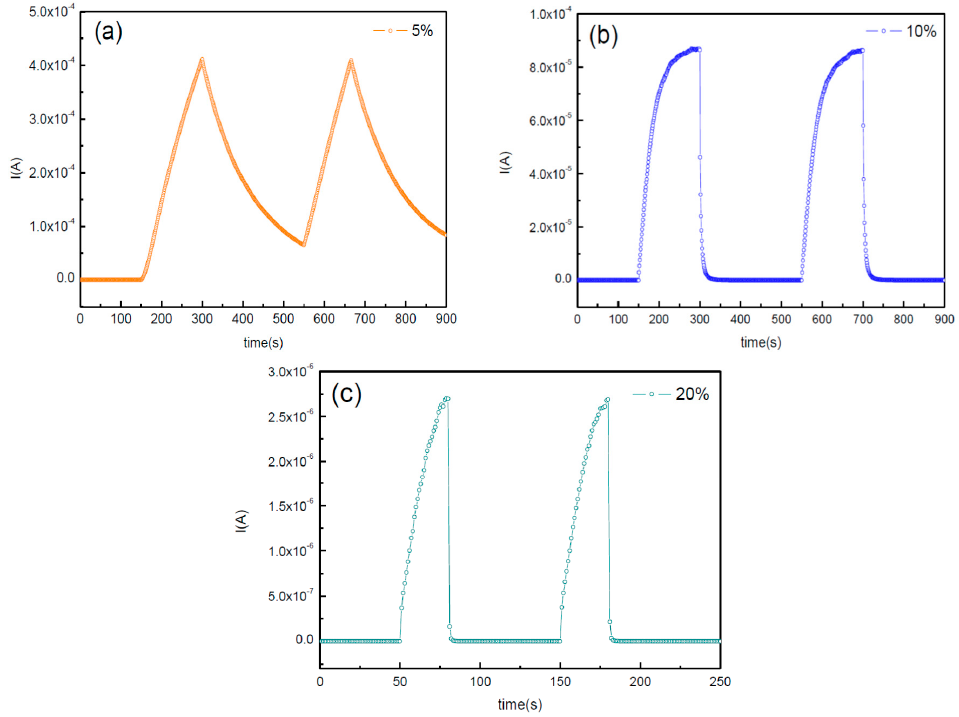
Figure 8. Time-dependent photoresponse of the IGO photodetector with ( a ) 5%; ( b ) 10%; and ( c ) 20%.